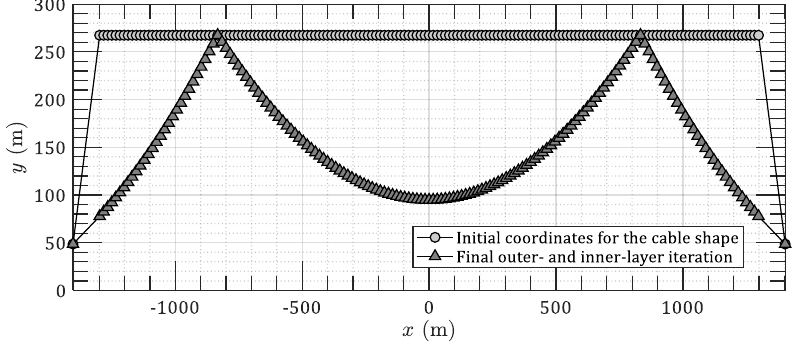
Figure 7. The cable shape from the initial coordinates to the target configuration for 2D parallel main cables.